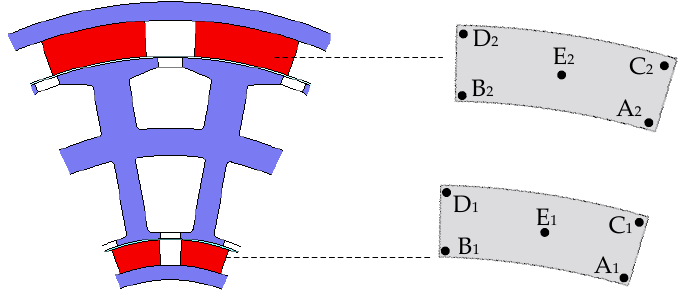
Figure 11. Different measuring points for analyzing the irreversible demagnetization characteristics.